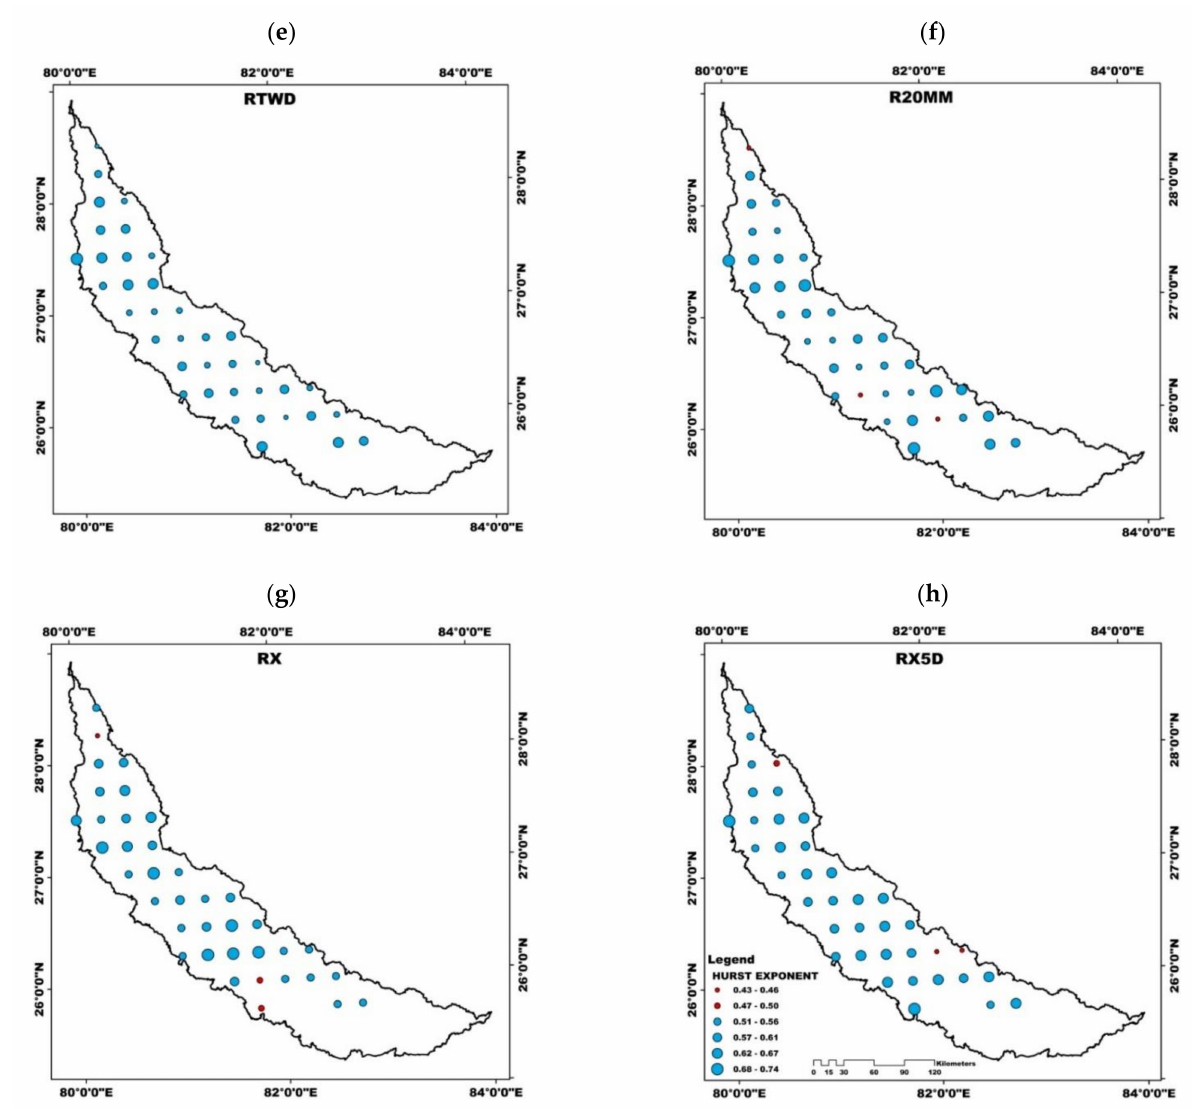
Figure 5. Spatial distribution map of extreme climate indices ( a ) R50MM, ( b ) D95P, ( c ) DD, ( d ) R95TOT, ( e ) RTWD, ( f ) R20MM, ( g ) RX, and ( h ) RX5D in Gomati Basin based on the Hurst